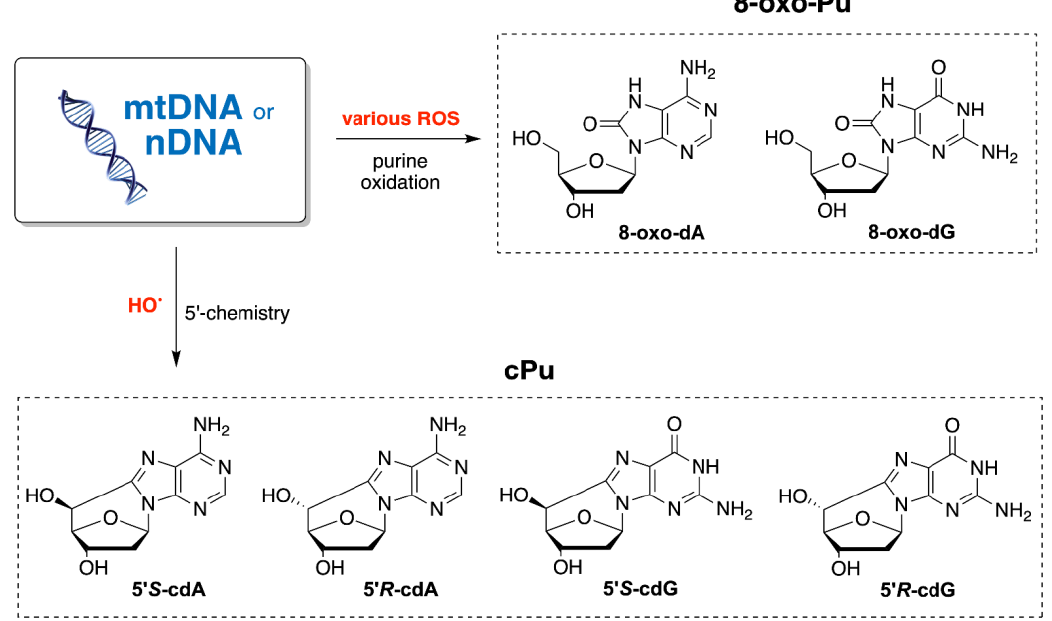
Figure 2. Structures of cPu lesions generated by H–atom abstraction from H5 (cid:48) position by HO